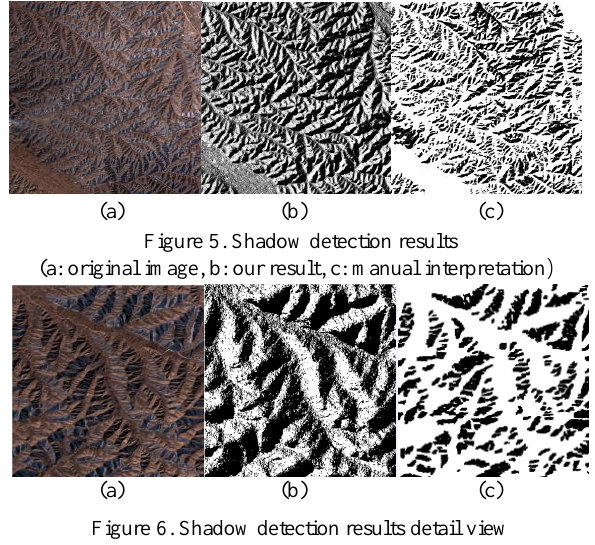
Figure 6. Shadow detection results detail